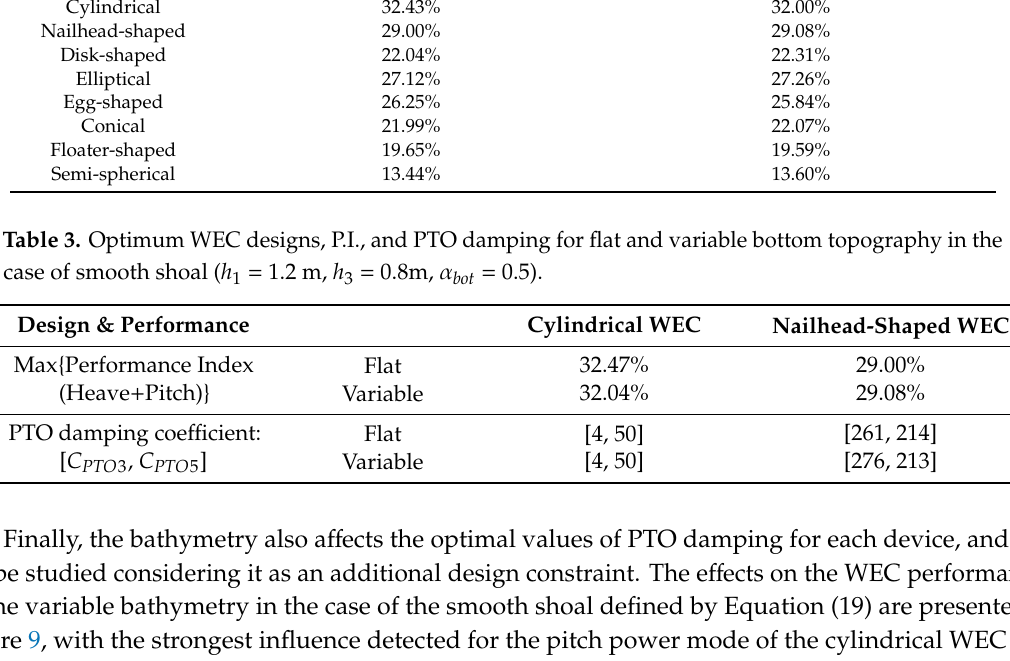
Table 3. Optimum WEC designs, P.I., and PTO damping for flat and variable bottom topography in the case of smooth shoal ( h 1 = 1.2 m, h 3 = 0.8m, α bot = 0.5).